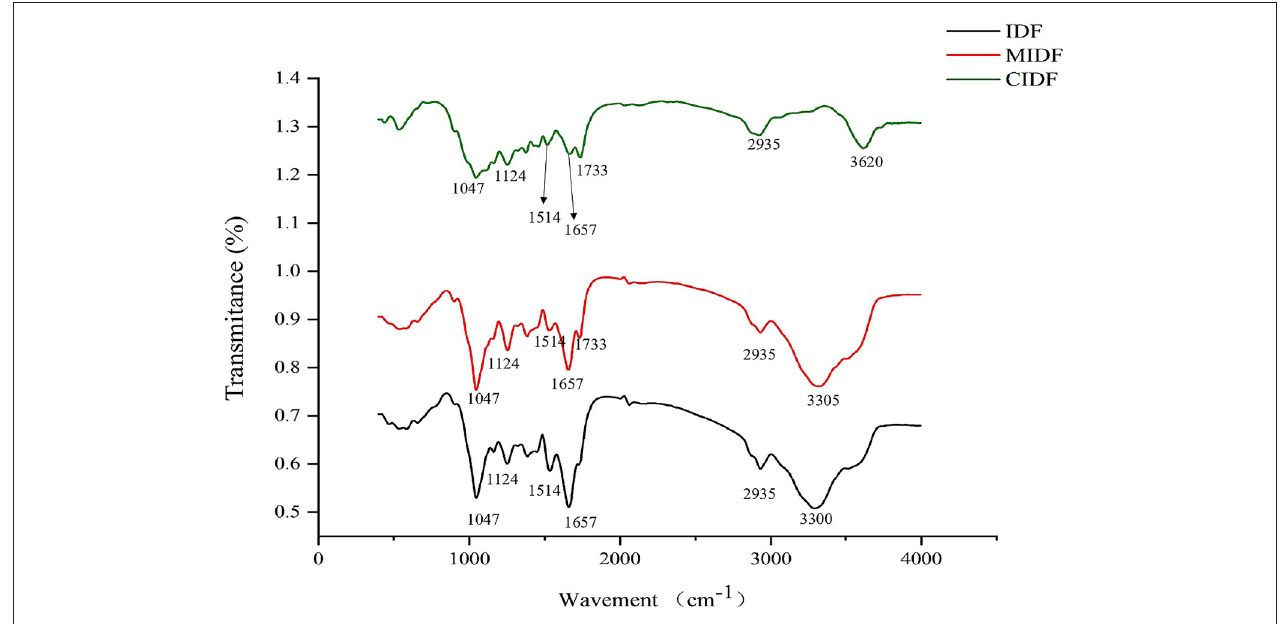
FIGURE 3 | FT-IR spectra of IDFs.